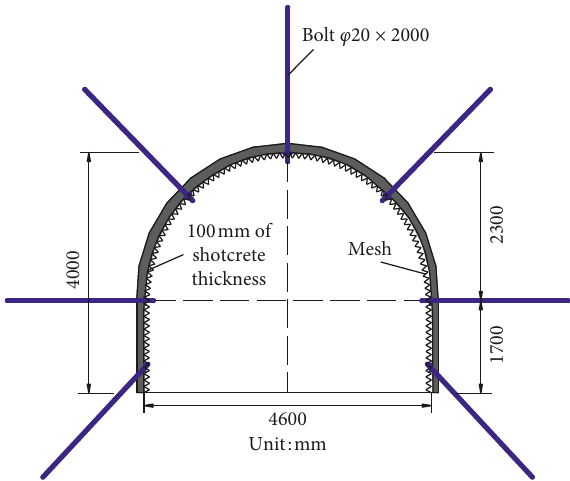
Figure 2: Original support